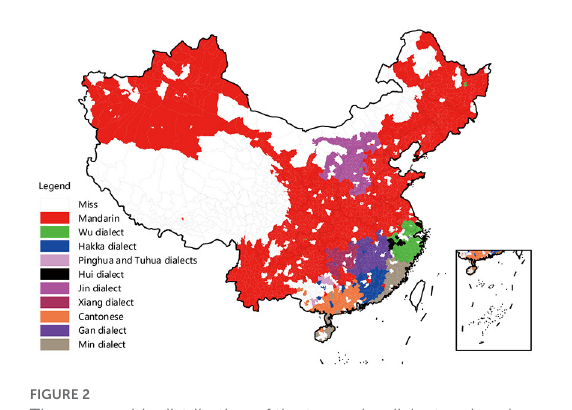
FIGURE2 The geographic distribution of the ten major dialect regions in China [Data source: The Chinese Dialect Dictionary (Revised Edition)].